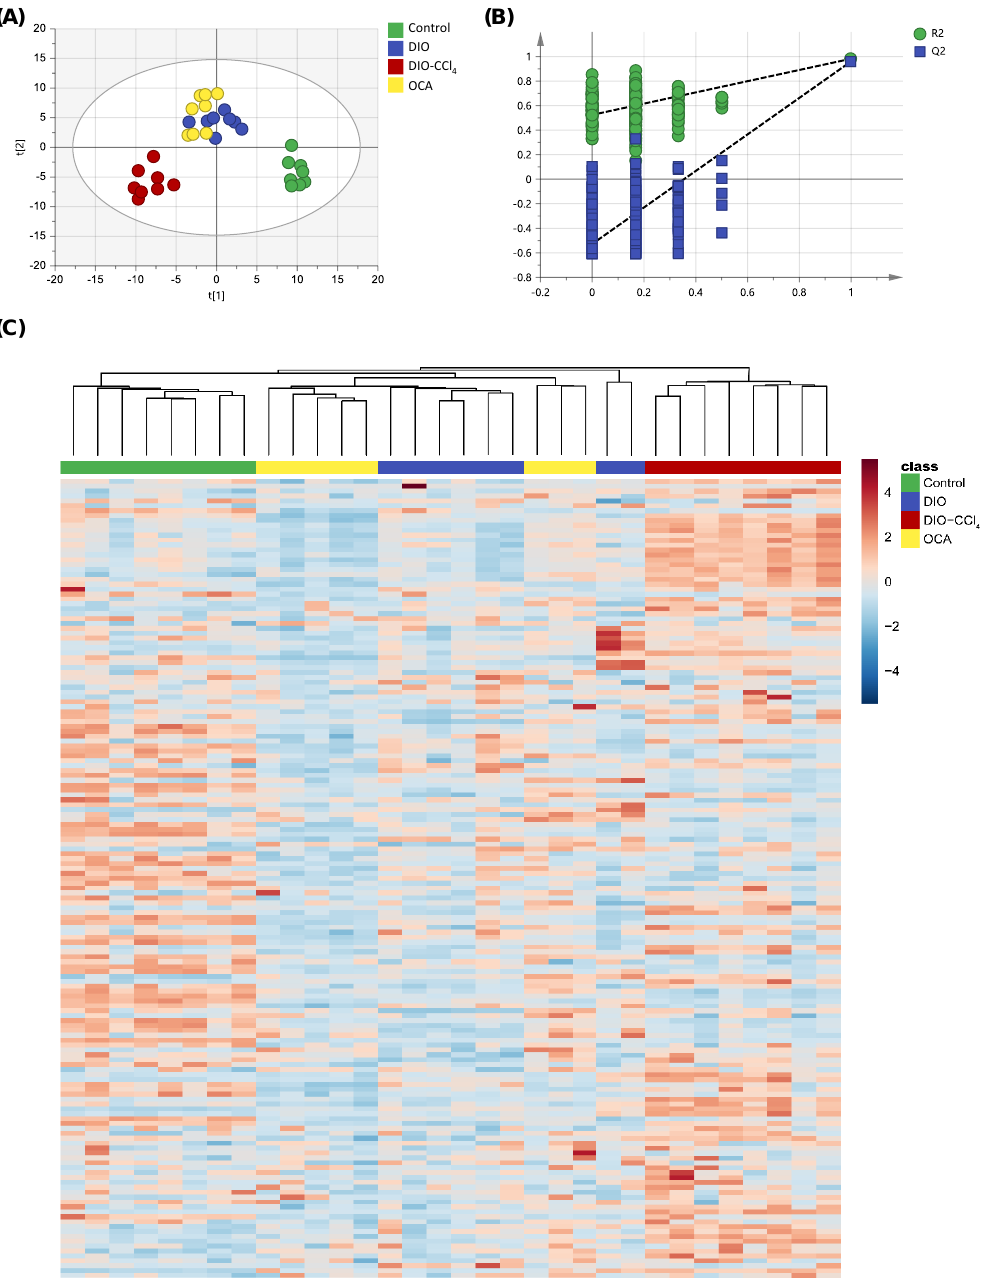
Figure 7. The metabolomic analysis of liver among control, model and OCA treated groups. ( A ) PLS-DA score plot of liver. ( B ) Model validation of PLS-DA using a permutation test with 200 cycles. ( C ) Heatmap of metabolic features of